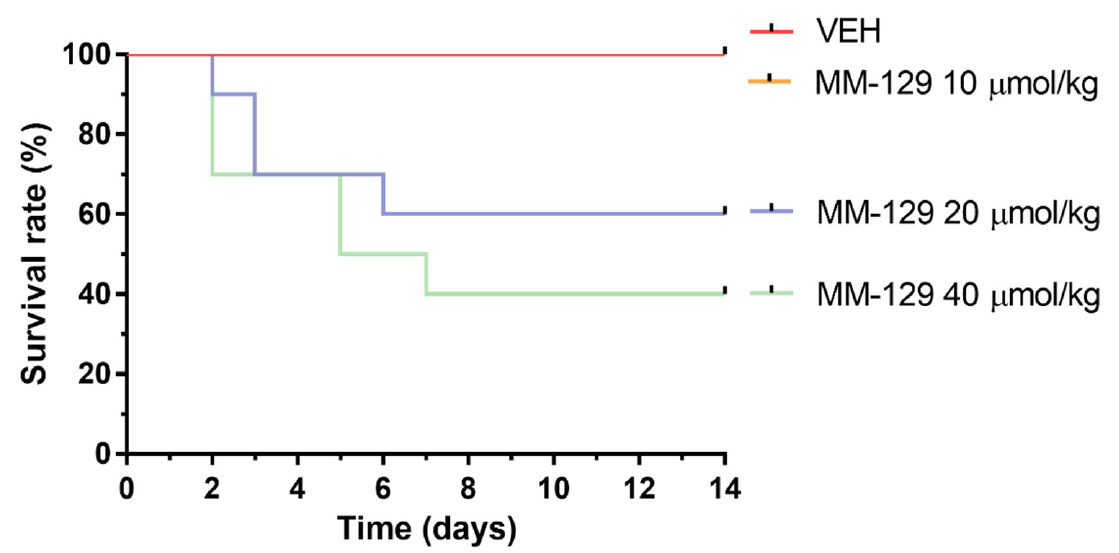
Figure 9. Survival rate of mice exposed to MM-129 concentrations and vehicle (VEH) after long-term administration. Abbreviations: MM-129—pyrazolo[4,3-e]tetrazolo[4,5-b][1,2,4]triazine sulfonamide; VEH—vehicle.